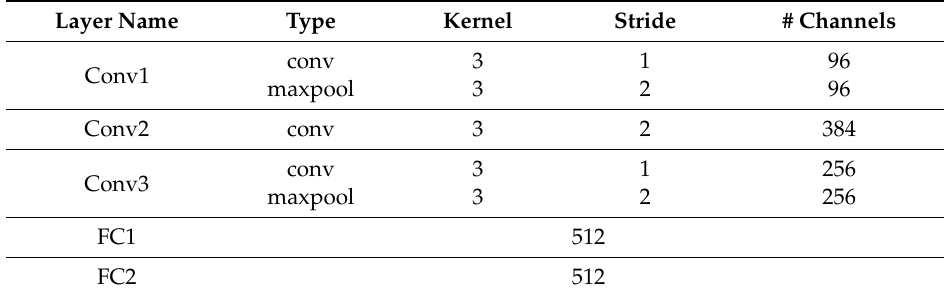
Table 2. Configuration of student network. Each convolutional layer and fully connected layer was followed by ReLU, which is not shown for